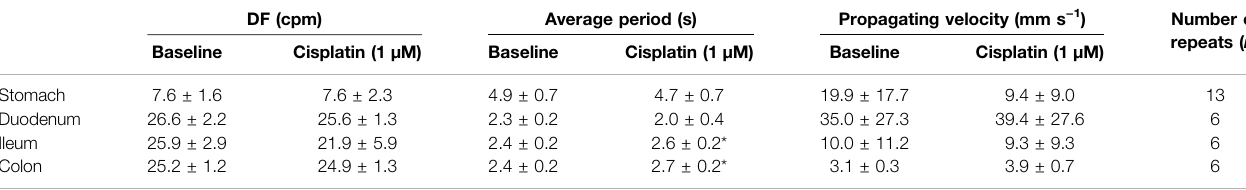
TABLE 1 | Effect of cisplatin (1 μ M) on the dominant frequency (DF), average period and propagating velocity, compared to